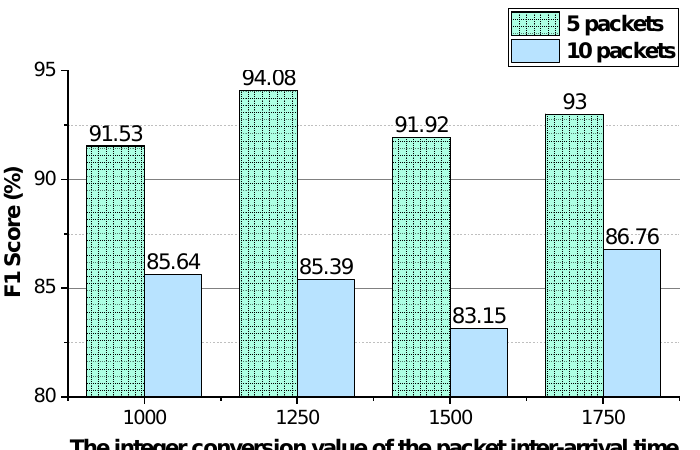
Figure 8. The VPN traffic detection performance of the method using different integer conversion values of packet inter-arrival